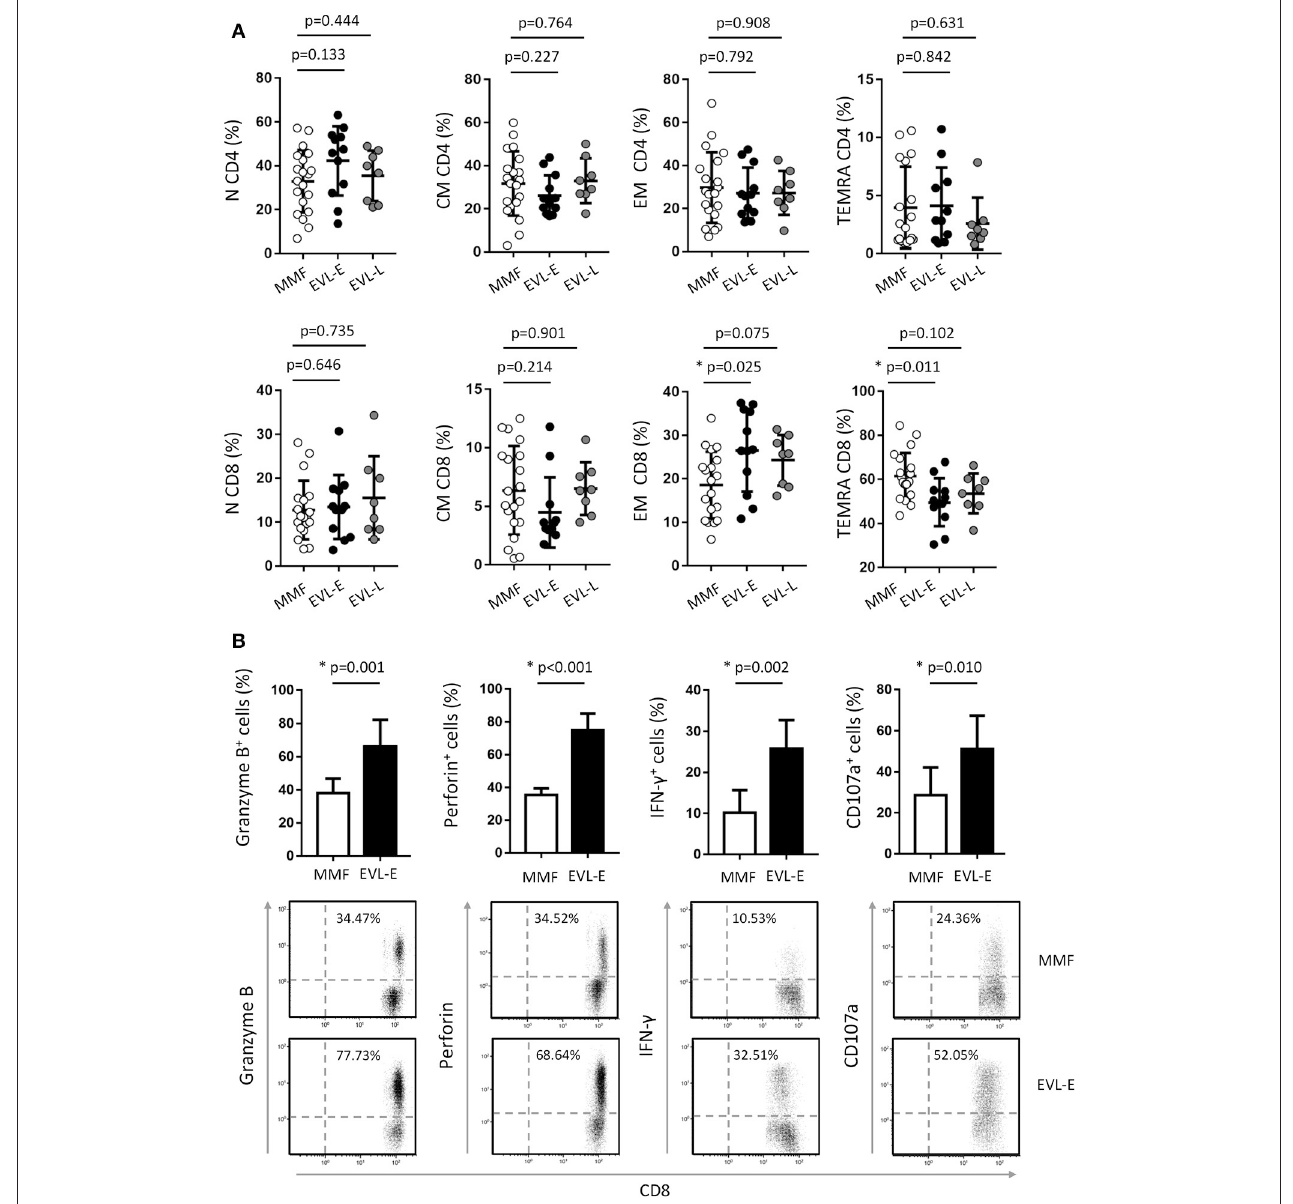
FIGURE 3 | Effect of EVL on the cell subsets of CD4 + and CD8 + T cells and functional properties of cytotoxic CD8 + T cells. (A) Distribution of CD4 + and CD8 + T lymphocytes into naive (N, CD45RA + CCR7 + ), central memory (CM, CD45RA − CCR7 + ), effector-memory (EM, CD45RA − CCR7 − ) and terminally differentiated effector-memory re-expressing CD45RA (TEMRA, CD45RA + CCR7 − ) subsets, in HT patients from MMF ( n = 20), EVL-E ( n = 12) and EVL-L ( n = 8) groups. (B) Histograms represent the percentage of CD8 + T lymphocytes expressing cytolytic molecules (Granzyme B and Perforin), producing IFN- γ cytokine or with the ability to degranulate (show by the cell-surface expression of the CD107a marker) for each patient from the MMF ( n = 20) and EVL-E ( n = 12) groups. Dot-plots are representative of an independent experiment from each treatment group. * p < 0.05.